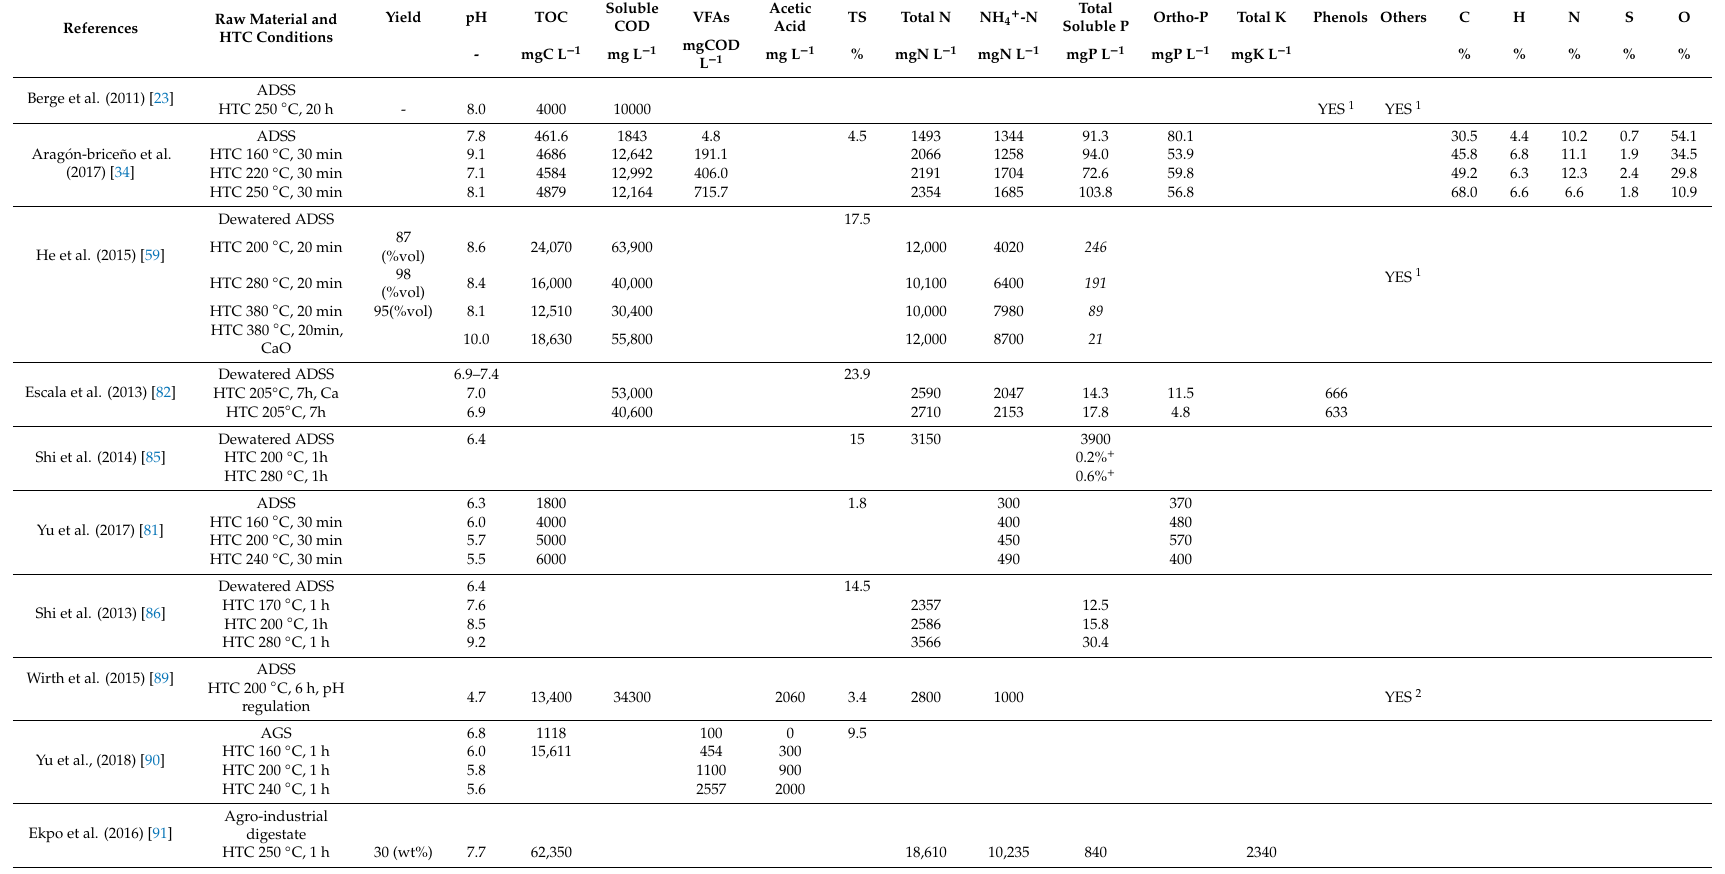
Table 3. Hydrothermal carbonization (HTC) process waters